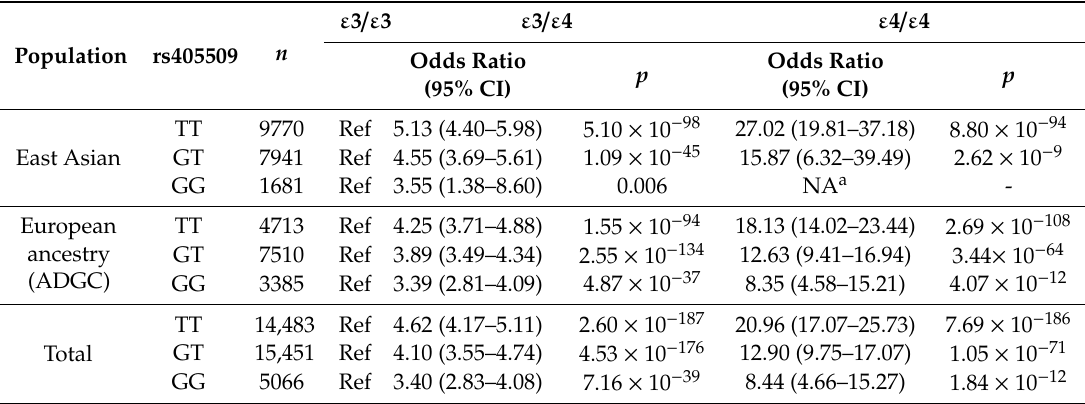
Table 2. Modifying e ff ect of rs405509 on association of APOE (apolipoprotein E) genotype and Alzheimer’s disease.